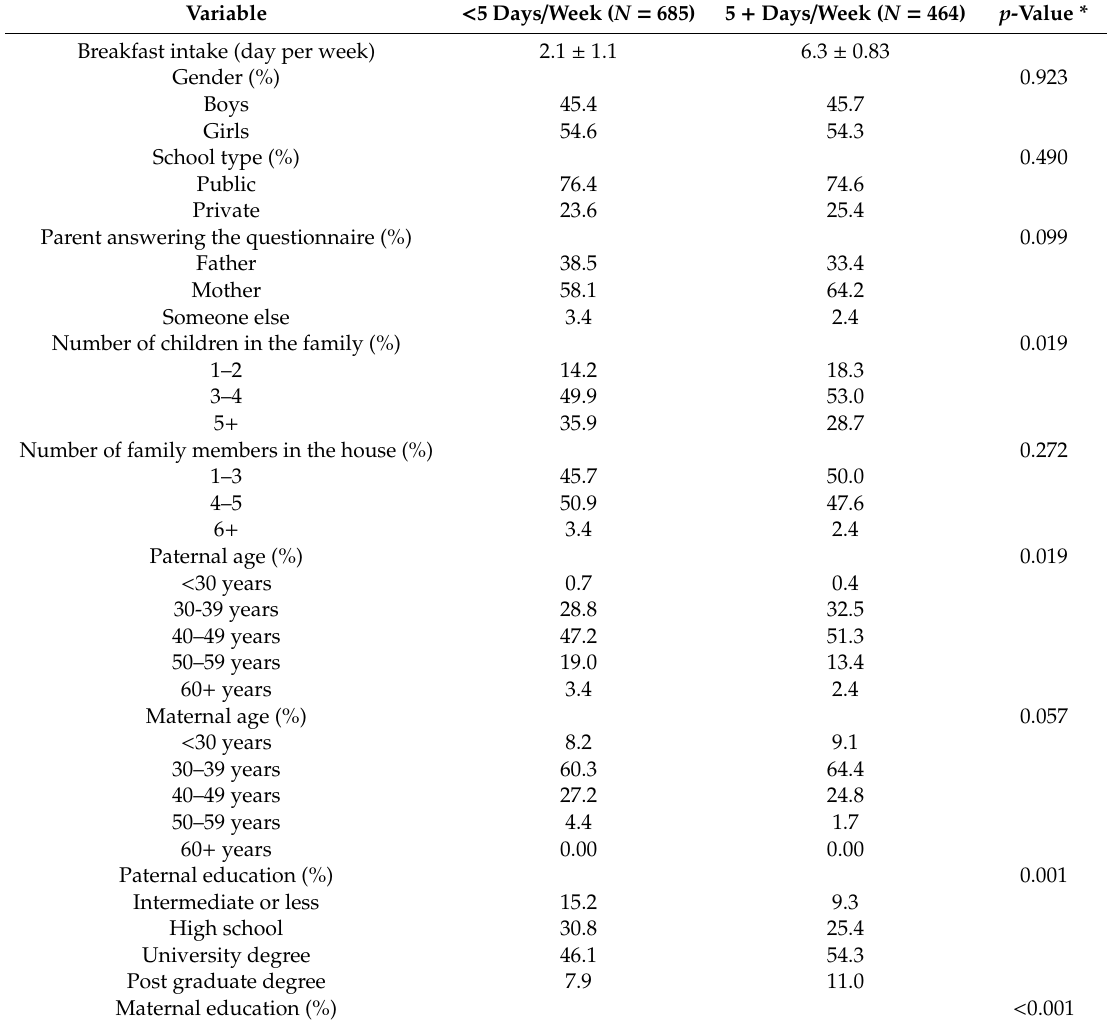
Table 3. Socio-demographic and lifestyle factors of the participants relative to high versus low breakfast intake